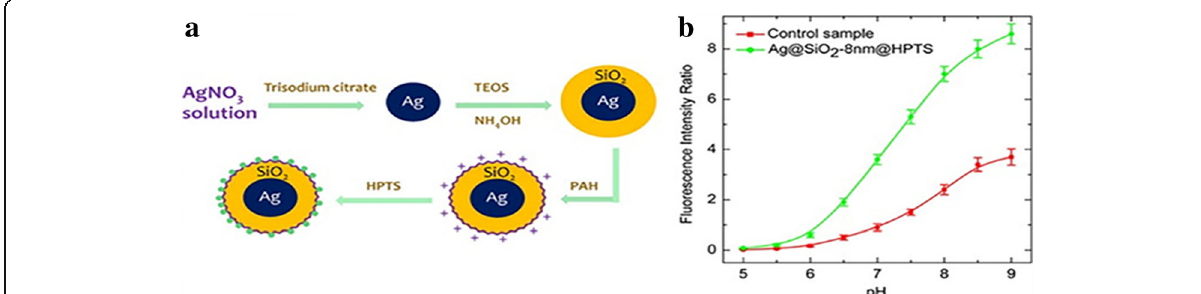
Fig. 10. What is more, the photoluminescence inten- sity could keep stable for several hours (even 24 h).